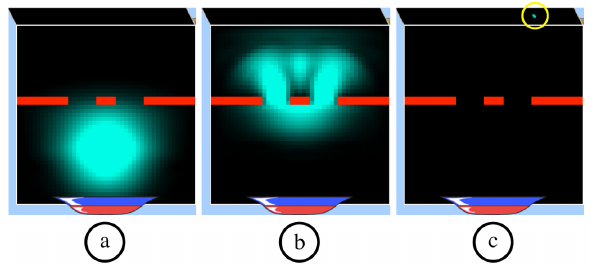
FIG. 2. A sequence of screen shots from the Quantum Wave Interference PhET simulation [43]: (a) a bright spot emerges from an electron gun, (b) passes through both slits, and (c) a single electron is detected on the far screen (highlighted in this figure by the circle). After many electrons, a fringe pattern develops (not